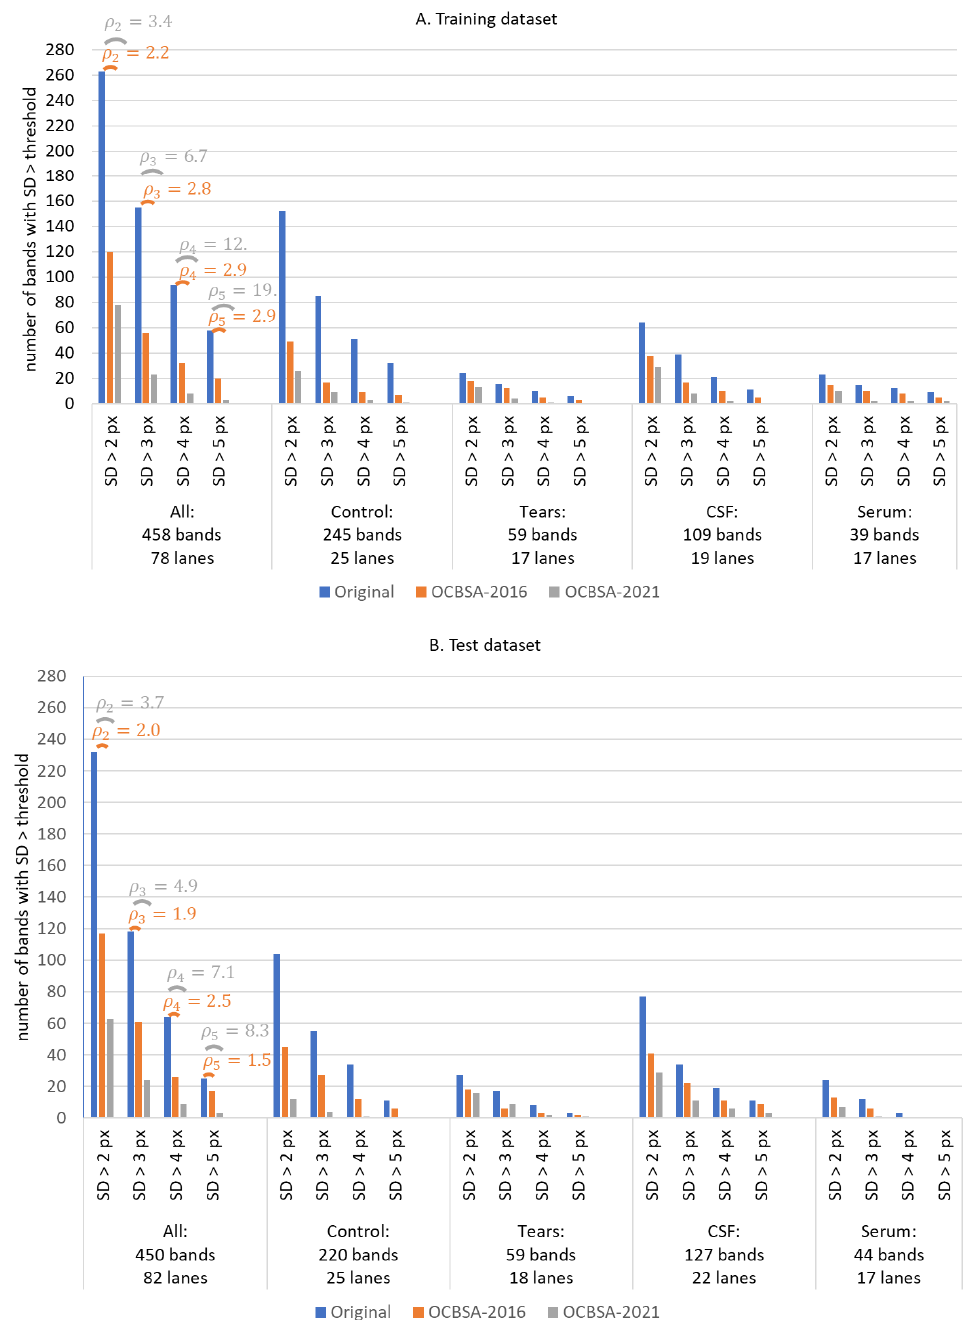
Figure 9. Band-straightening results for the real IEF training ( A ) and test ( B ) datasets: the number of bands with different deformation thresholds (SD > 2 pixels, 3 pixels, 4 pixels, 5 pixels) before straightening, after OCBSA-2016 and after OCBSA-2021 are displayed for the whole dataset and for 𝑛𝑢𝑚 𝑏𝑒𝑓𝑜𝑟𝑒𝑡 each sample type (control, tears, CSF, and serum). The 𝜌 𝑡 = ratios with the different 𝑛𝑢𝑚 𝑎𝑓𝑡𝑒𝑟𝑡 deformation thresholds are shown for the whole dataset (orange for OCBSA-2016, grey for OCBSA- 2021).